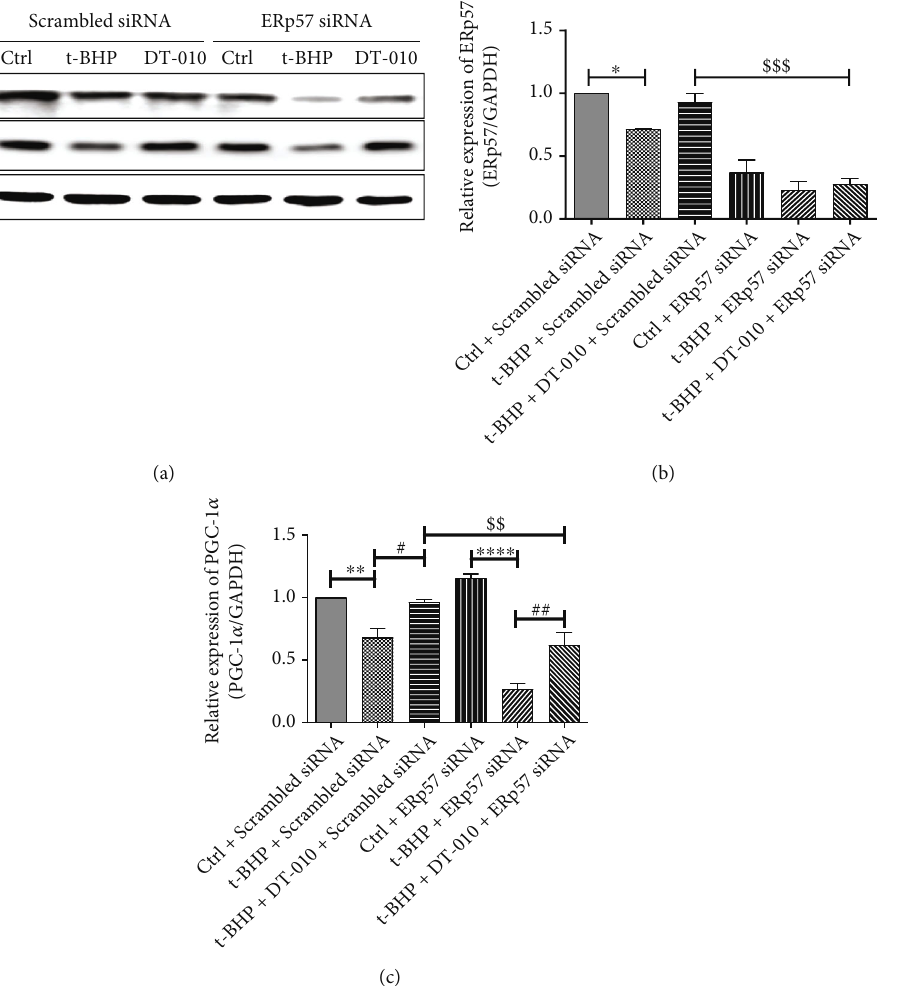
Figure 5: Knockdown ERp57 by speci fi c shRNA abolished the upregulation of DT-010 on PGC-1 α protein expression in H9c2 cells. (a) Representative Western blot of ERp57 and PGC-1 α . (b, c) Quanti fi cation of Western blot band density of ERp57 (b) and PGC-1 α (c). Data are mean ± SD of two independent experiments. ∗ P < 0 : 05 , ∗∗ P < 0 : 01 , and ∗∗∗∗ P < 0 : 0001 ; # P < 0 : 05 and ## P < 0 : 01 ; $$ P < 0 : 01 and $$$ P < 0 : 001 . Data were analyzed using one-way ANOVA and Tukey ’ s multiple comparison